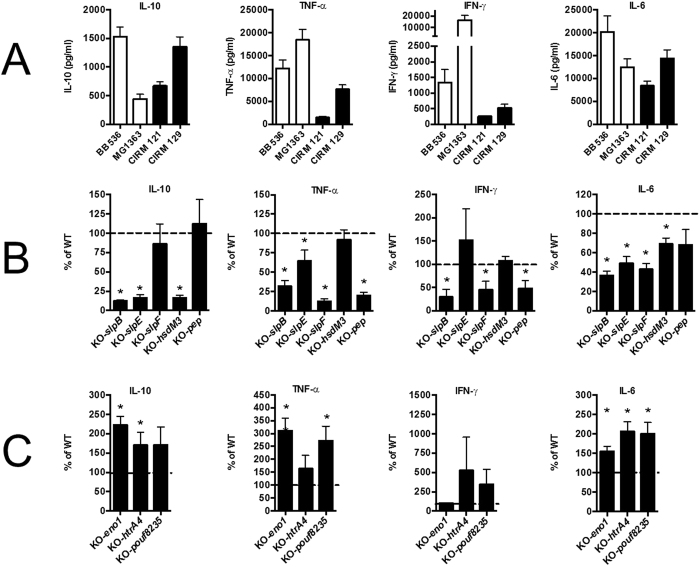
Immunological consequences of the inactivation of selected genes.Panel (A) Comparative IL-10, TNF-α, IFN-γ and IL-6 cytokine responses of human PBMCs stimulated by the two strains used as positive controls Lactococcus lactis MG1363 (pro-inflammatory) and Bifidobacterium longum BB536 (anti-inflammatory) or by two wild type Propionibacterium freudenreichii strains, CIRM 121 and CIRM 129. Panel (B) Cytokine induction by the mutant strains inactivated for the five genes positively associated with IL-10: slpB, slpE, slpF, hsdM3 and pep, expressed as a percentage of the strong anti-inflammatory wild type CIRM 129 strain. Panel C. Cytokine induction by mutant strains inactivated for eno1, htrA4, pouf8235, negatively associated with IL-10, and expressed as a percentage of the weak anti-inflammatory wild type CIRM 121 strain. Data were expressed as means +/− SEM. Symbols: *P < 0.05.